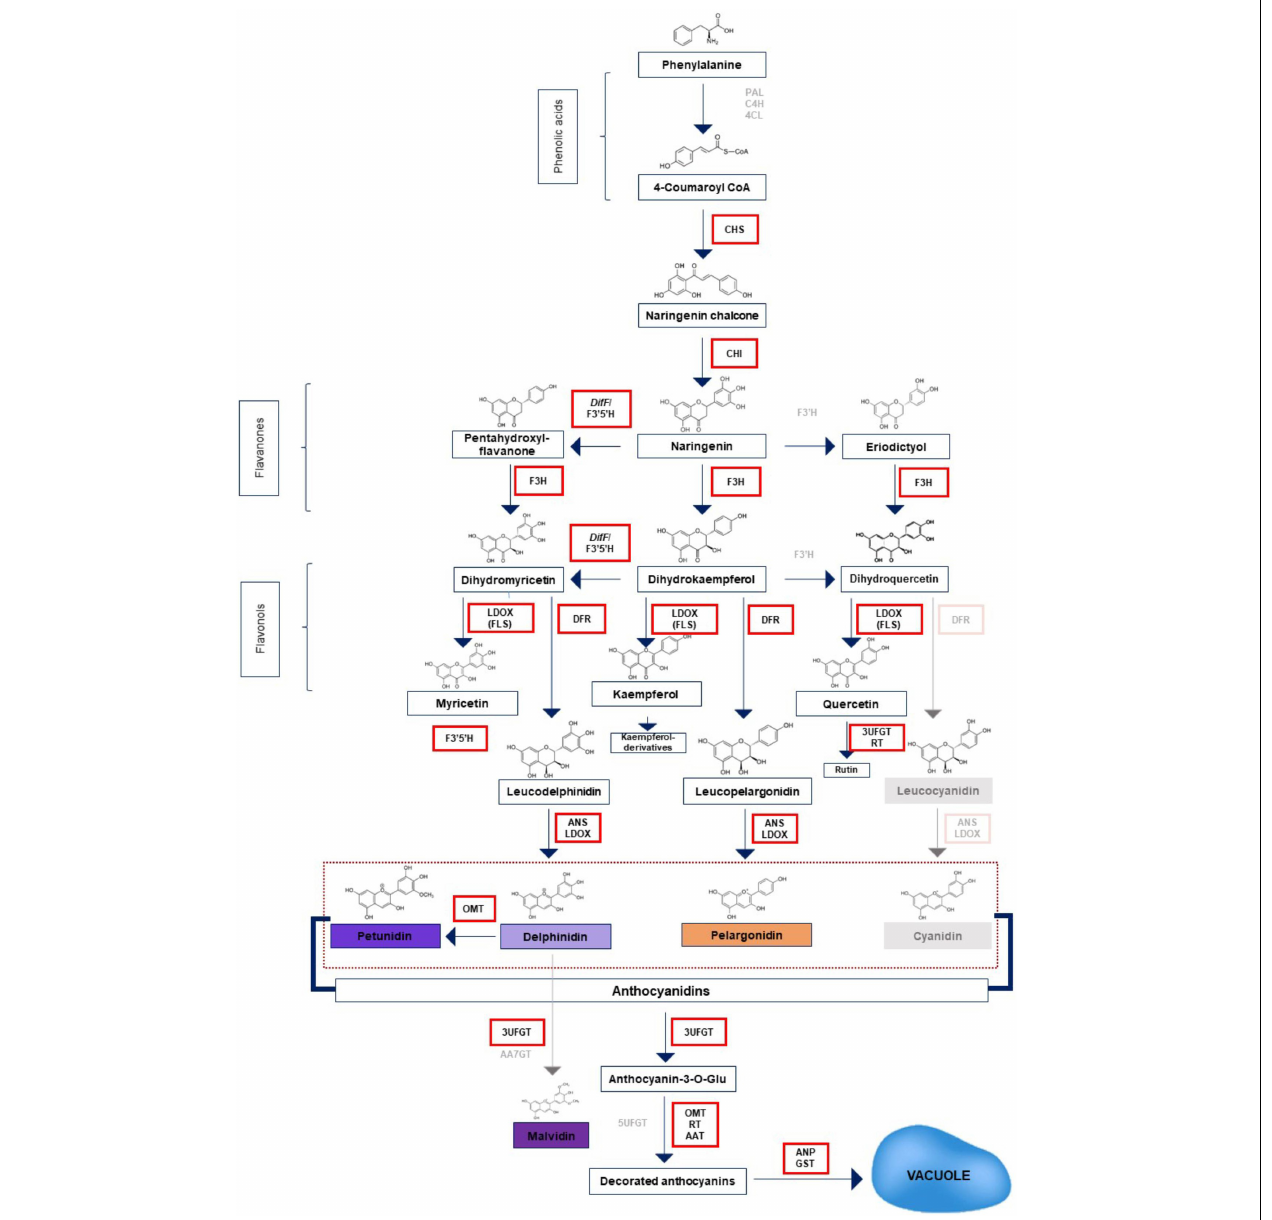
FIGURE 6 | Schematic diagram of the anthocyanin biosynthetic pathway. The structural genes upregulated by ectopic expression of PhAN4 in MicroTom HRCs and leading to accumulation of compounds are in black and marked by red boxes. PAL, phenylalanine ammonia-lyase; C4H, cinnamate-4-hydroxylase; 4CL, 4-coumarate CoA ligase; CHS, chalcone synthase; CHI, chalcone isomerase; F3 (cid:48) H, flavonoid-3 (cid:48) -hydroxylase; F3 (cid:48) 5 (cid:48) H, flavonoid-3 (cid:48) ,5 (cid:48) -hydroxylase; DFR, dihydroflavonol reductase; ANS, anthocyanin synthase; OMT, O-methyltransferase; AAT, anthocyanin acyltransferase; RT, rhamnosyltransferase; UFGT, UDP-glucose flavonoid 3- O -glucosyl transferase; AA7GT, cyanidin-3- O -glucoside-7- O -glucosyltransferase; ANP, anthocyanin permease; GST, glutathione- S -transferase.